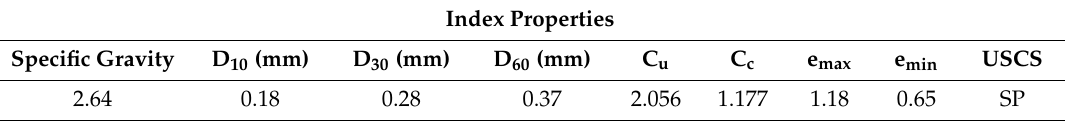
Table 2. Material properties of sand obtained from Nakdong River.